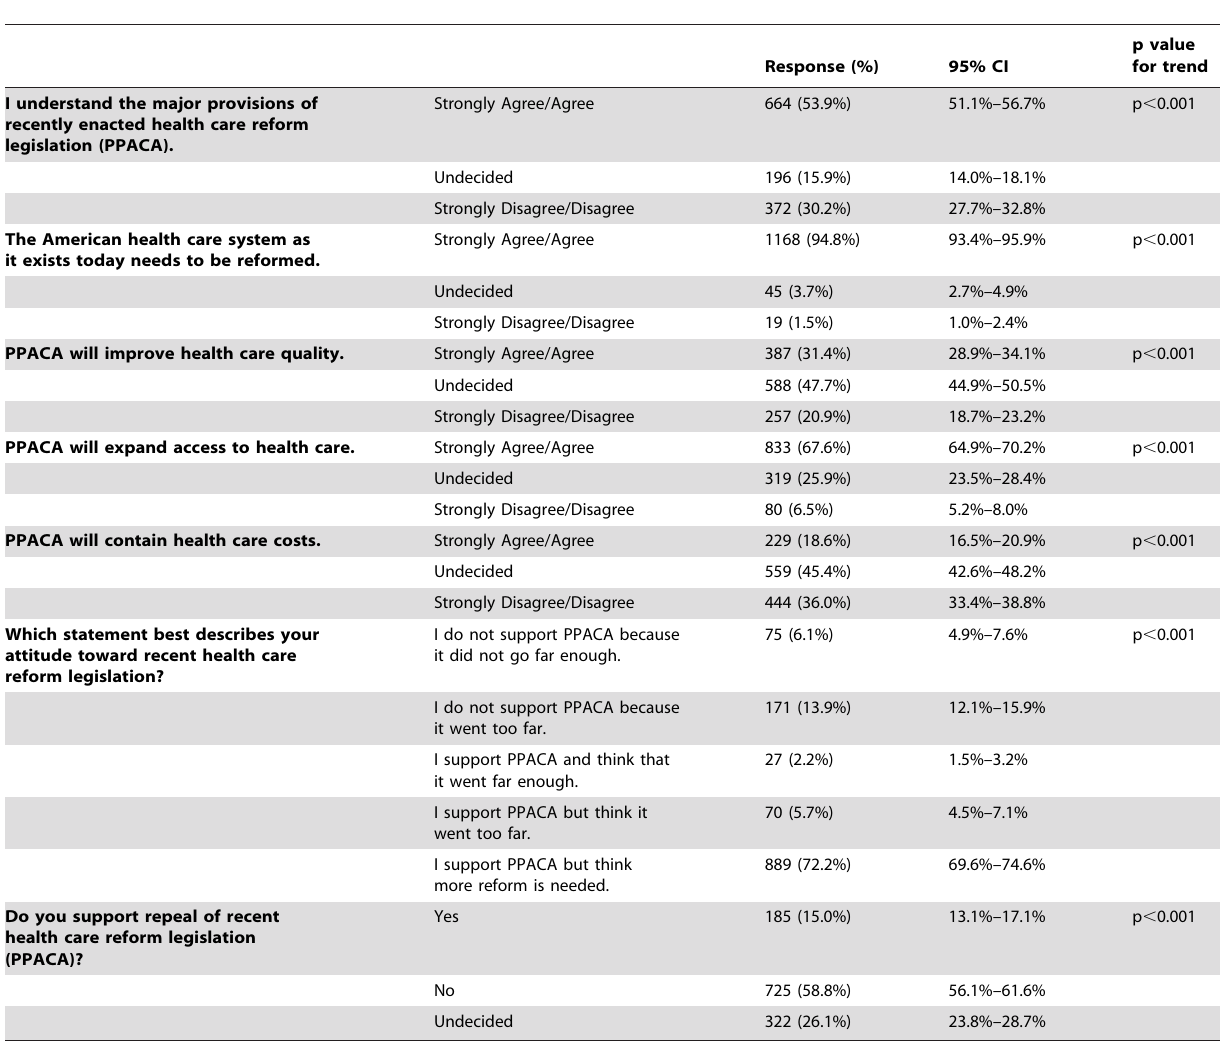
Table 2. Responses about the Patient Protection and Affordable Care Act